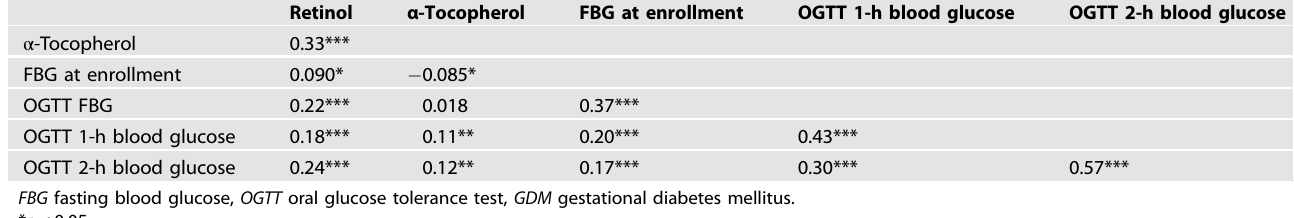
Table 3. Pearson correlations of retinol and α -tocopherol with FBG at enrollment, OGTT FBG, OGTT 1-h and 2-h blood glucose levels in women with non-GDM ( n = 574).